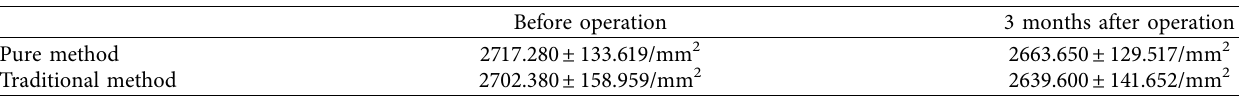
Table 8: Comparison of corneal endothelial cell density within and between the pure ICL implantation and the traditional ICL implantation groups.